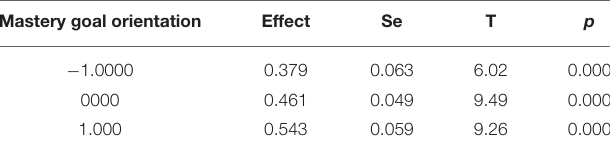
TABLE 3 | Slopes for self-efficacy predicting grades at each level of mastery goal